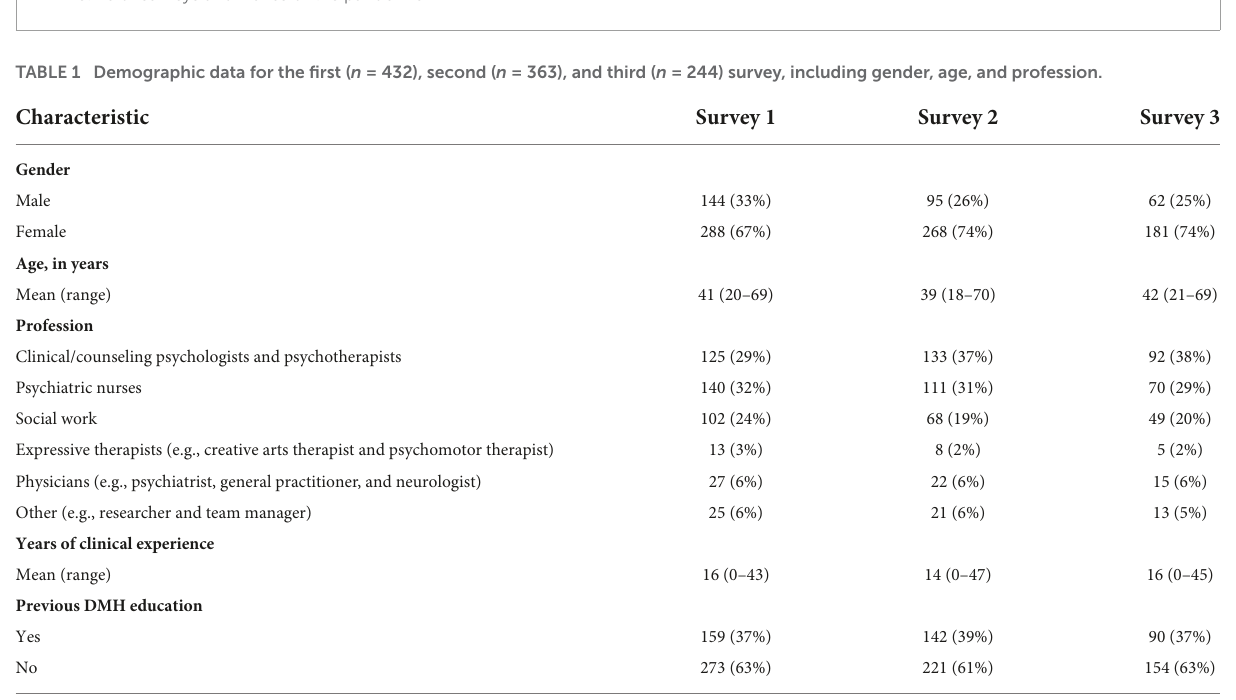
FIGURE1 Timeline of surveys and waves of the pandemic.